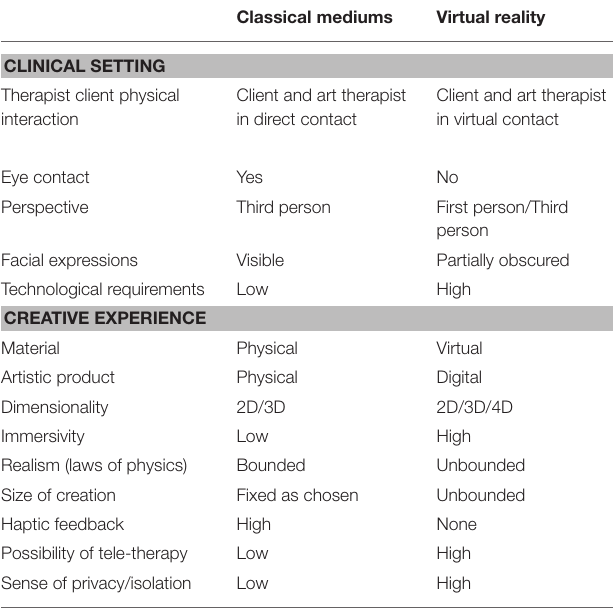
TABLE 1 | Comparison of VR art therapy and classical Art therapy